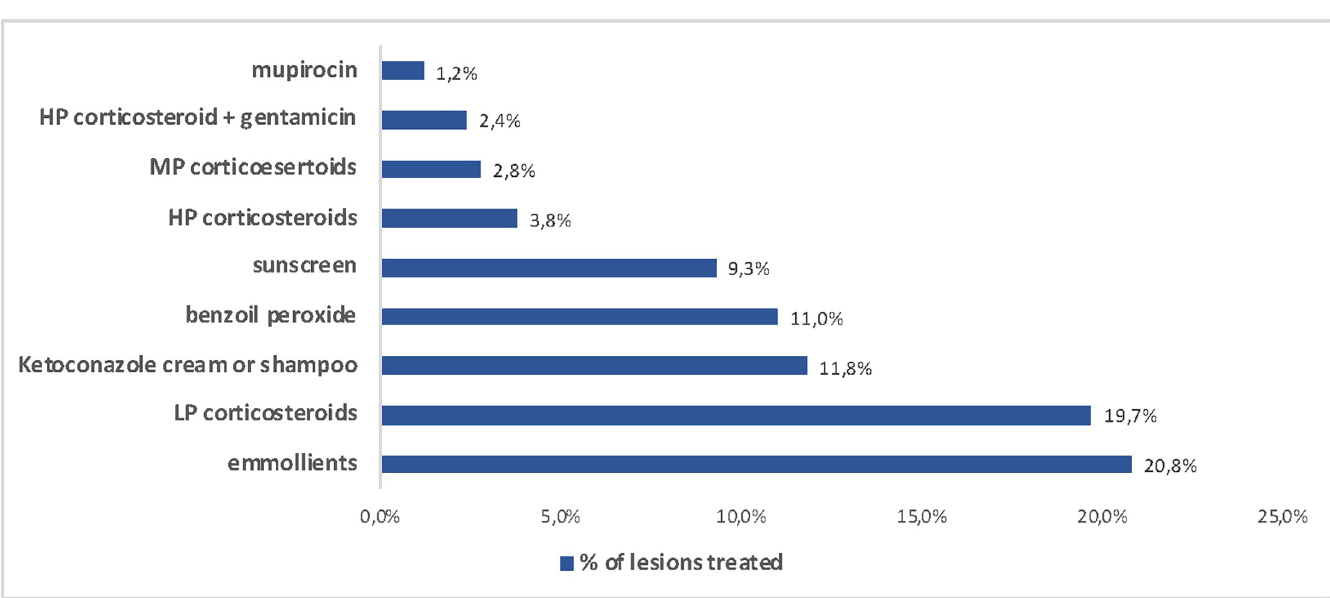
Fig 4. List of most frequent prescriptions made by teledermatologists for patients 0–19 years old who participated in the Teledermatology Project from July 2017-July 2018, in the city of S ã o Paulo.